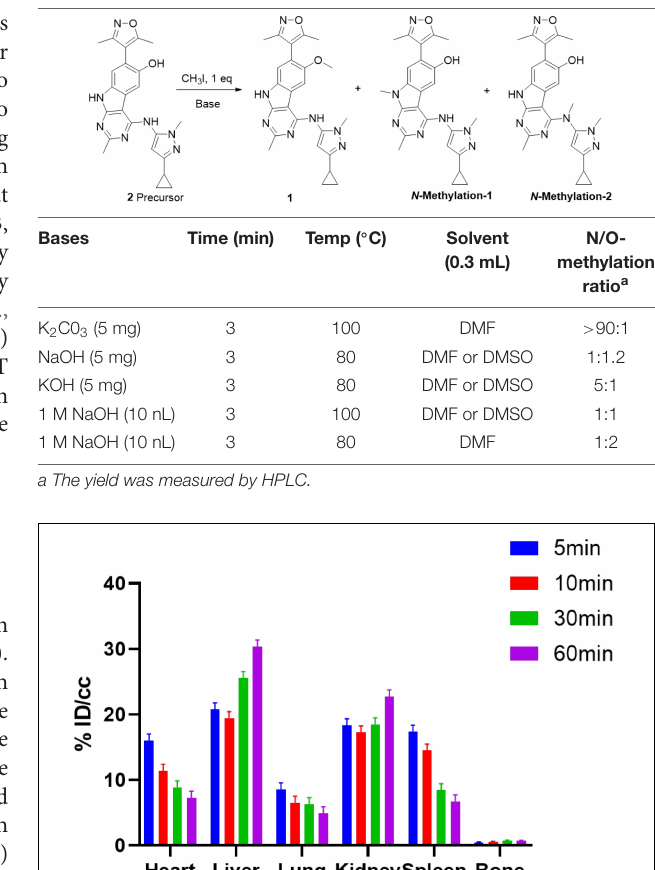
TABLE 1 | Assessment of N-methylation to O-methylation selectivity for various reaction